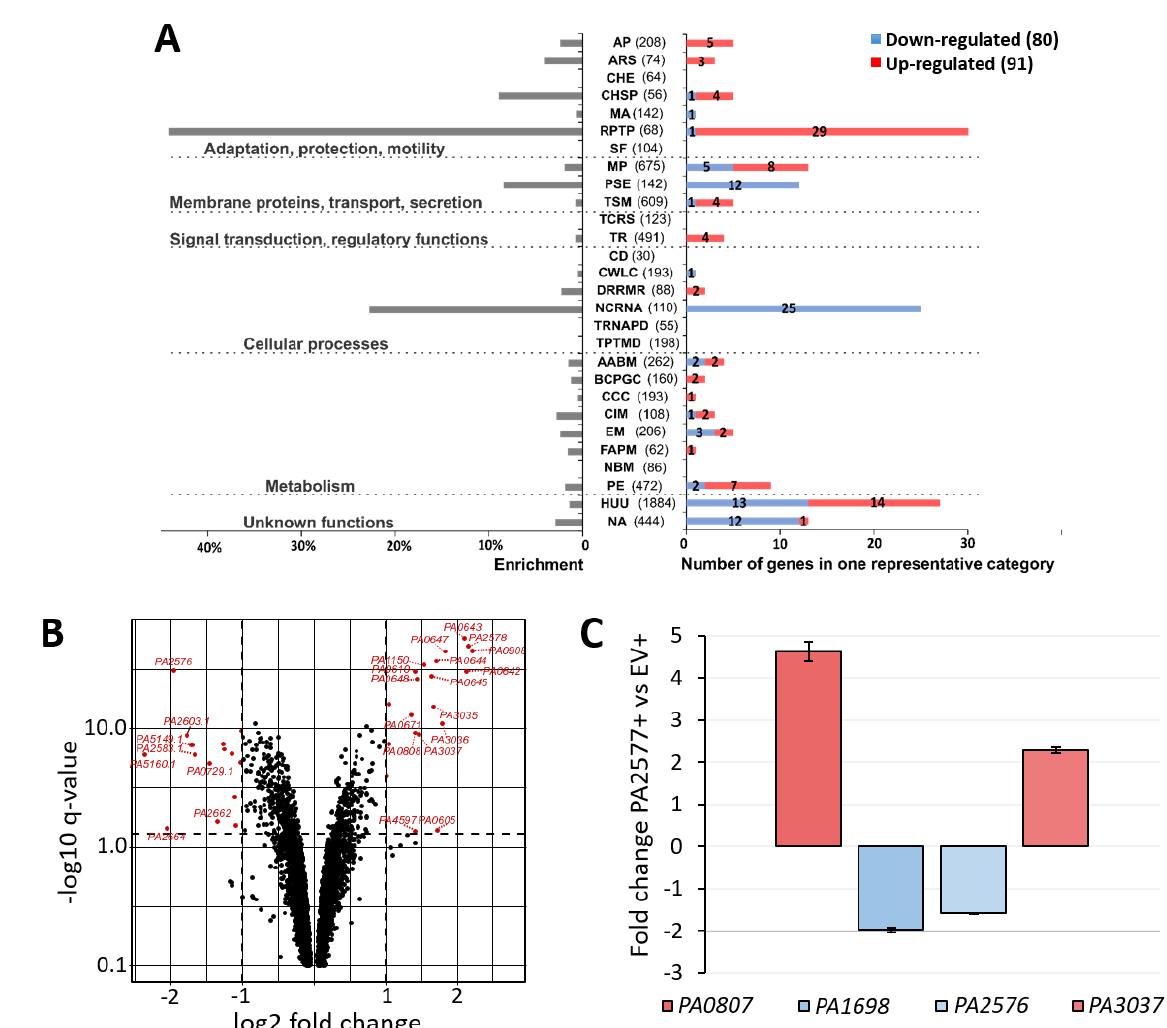
Figure 3. Identification of P. aeruginosa genes affected by PA2577. ( A ) Comparative transcriptome analysis was performed for PA2577 overproducing cells (PA2577+) vs. EV+ P. aeruginosa PAO1161 cells. Enrichment of PseudoCAP functional categories [32] for 171 genes showing changes in mRNA level in response to mild PA2577 abundance (FC ≤ −1.5 or ≥1.5,